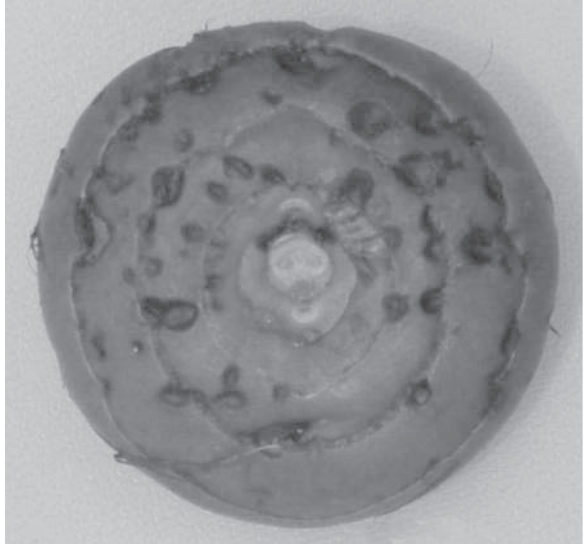
Fig. 2. Corm of gladiolus cv. American Beauty infected with Fusarium oxysporum f. sp. gladioli and showing concentric lesions of brown rot.